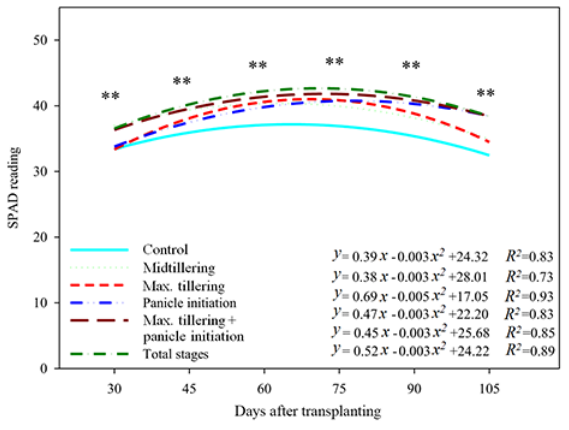
Figure 3 Effect of the foliar application of nutrients on the chlorophyll content in different growth stages using the linear regression